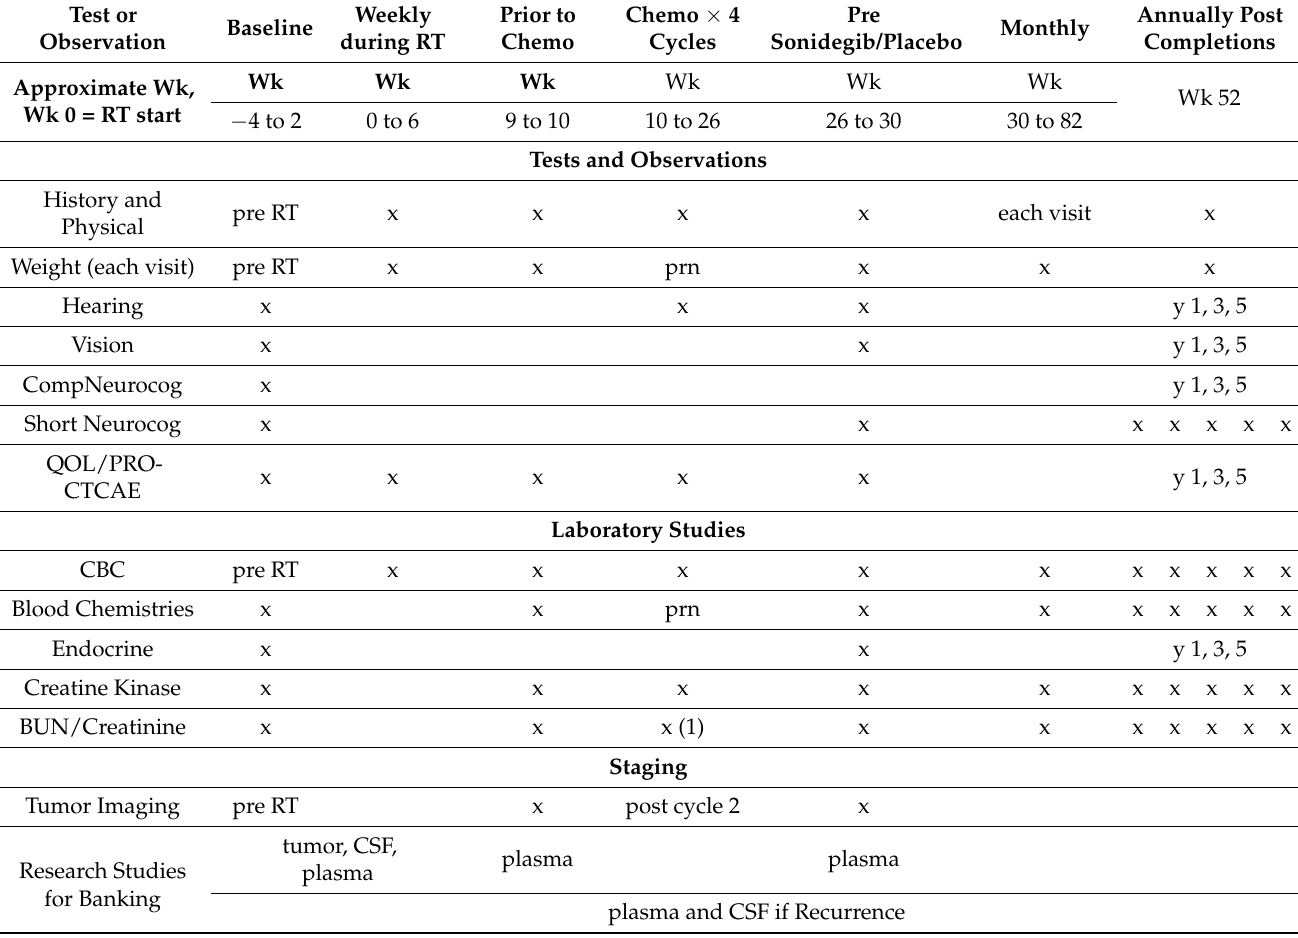
Table 3. Baseline and subsequent tests and observations for patients enrolled on the AMBUSH